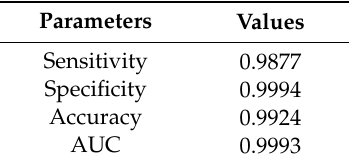
Table 5. Key parameters of the classifier with the optimal feature subset after 100 rounds of ten-fold